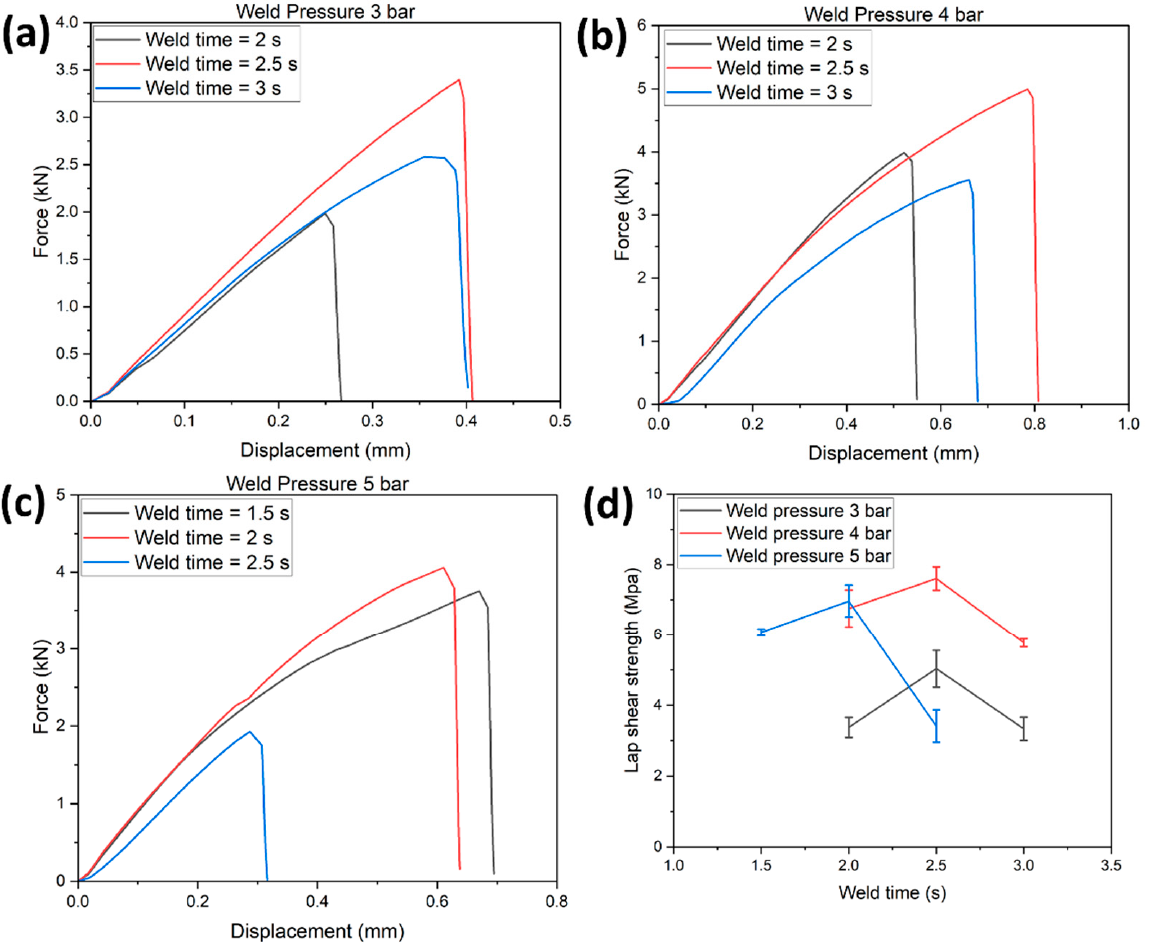
Figure 7. Load-displacement curve for EL-EP (Elium ® - Epoxy)_0.125_0.125: ( a ) Weld pressure = 3 bar, ( b ) Weld pressure = 4 bar, ( c ) Weld pressure = 5 bar. ( d ) Lap shear strength vs. Weld time.